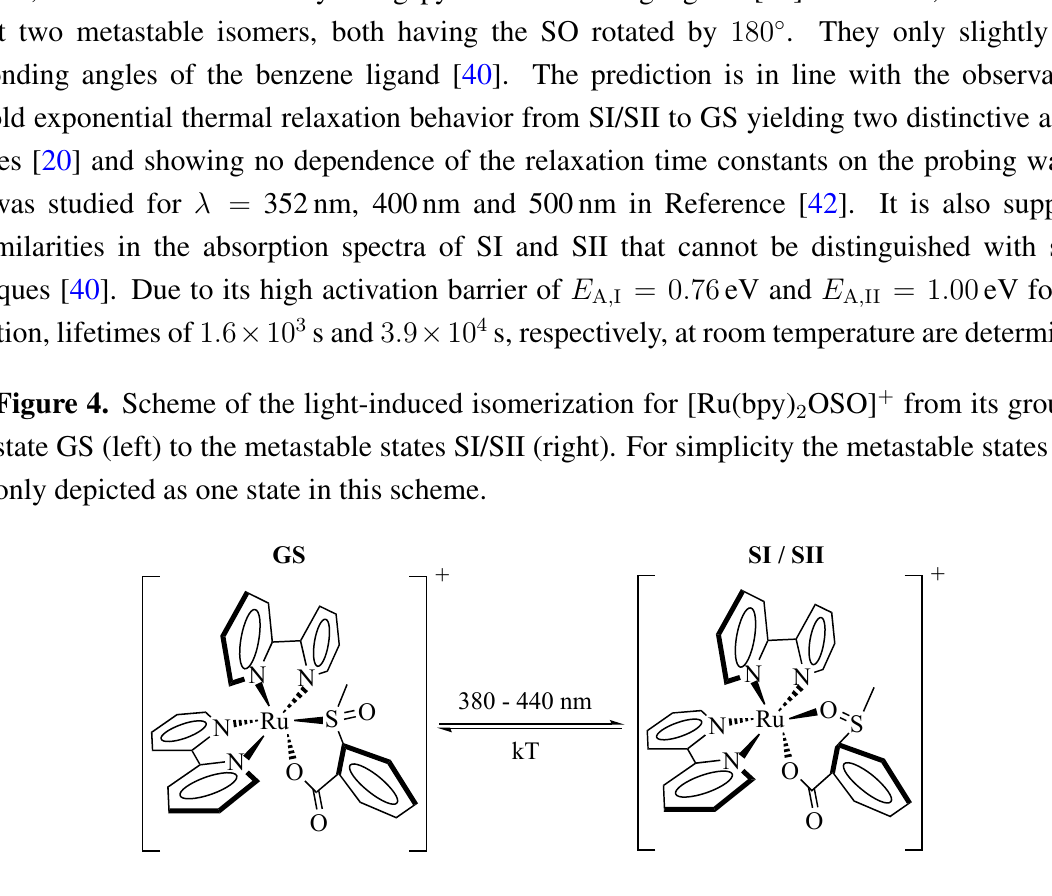
OSO] + from its ground 2